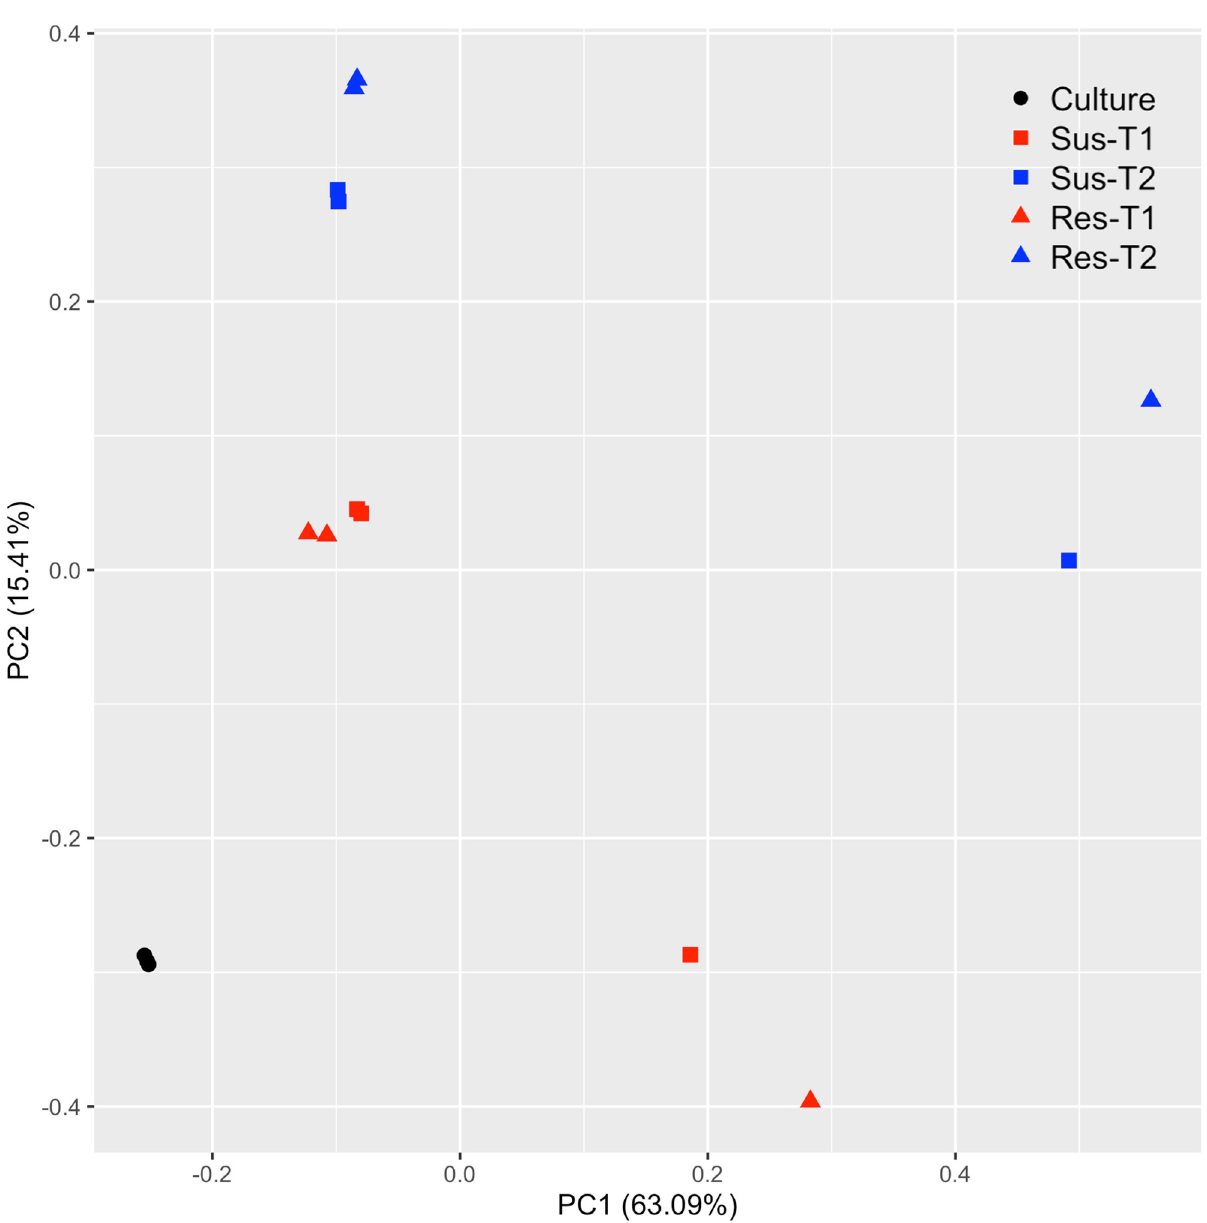
Fig 2. Principal component analysis of transcriptome expression. The PCA plot for RNA-Seq data shows the clustering of transcriptome by sample type (culture vs in planta ) and time of sample collection (T1 vs. T2).